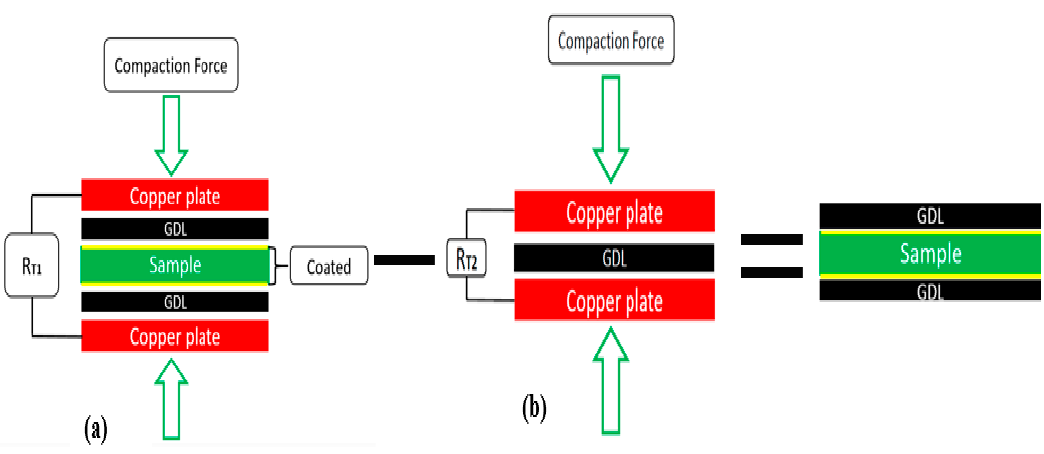
Figure 4. The arrangement schematic of the total resistances: ( a ) R_T1 and ( b ) R_T2 . The total resistance ( 𝑅 ) of the schematic in Figure 4a was obtained by applying the (cid:3021)(cid:2869) compaction force and measuring 𝑅 using a milliohm meter. The total resistance, which (cid:3021)(cid:2869) is given by Equation (1), can be calculated by the summation of the bulk resistance of two copper plates ( 2𝑅 (cid:3004)(cid:3048) ) , the GDL ( 2𝑅 (cid:3008)(cid:3005)(cid:3013) ), the contact resistance between copper GDL and ( 2𝑅 (cid:3004)(cid:3048)(cid:2879)(cid:3008)(cid:3005)(cid:3013) ), the internal resistance (power source, resistance in the wire, 𝑅 (cid:3036) , etc.), and the contact resistance between BPPs and GDL ( 2𝑅 (cid:3003)(cid:3017)(cid:2879)(cid:3008)(cid:3005)(cid:3013) ) . 𝑅 (cid:3021)(cid:2869) = 2𝑅 (cid:3004)(cid:3048) + 2𝑅 (cid:3004)(cid:3048)(cid:2879)(cid:3008)(cid:3005)(cid:3013) + 2𝑅 (cid:3008)(cid:3005)(cid:3013) + 2𝑅 (cid:3003)(cid:3017)(cid:2879)(cid:3008)(cid:3005)(cid:3013) + 𝑅 (cid:3003)(cid:3017) + 𝑅 (cid:3036) (1) To measure the value of 2𝑅 (cid:3003)(cid:3017)(cid:2879)(cid:3008)(cid:3005)(cid:3013) , in accordance with Figure 4b, the following equa- tion was utilized.